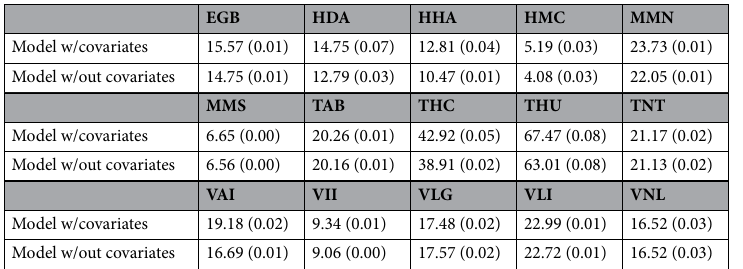
Table 1. RMSE for both models. The standard errors of the RMSEs are in parenthesis. Larger standard errors indicate larger variations in posterior curves. This variation can be reflected in the widths of ribbons in Fig.